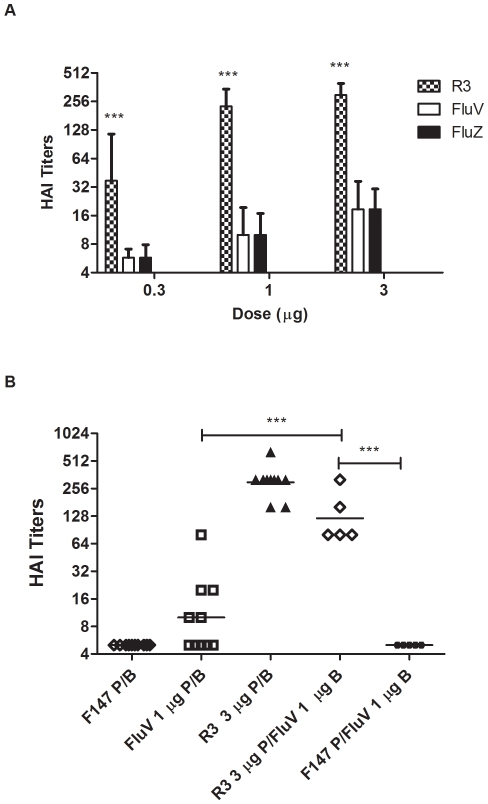
HAI titers of mice immunized with STF2R3.HA1, and/or TIV.Mice (n = 10) were primed (P) and boosted (B) with F147, STF2R3.HA1 (R3), Fluvirin (FluV), or Fluzone (FluZ) at the indicated doses on days 0 and 21, and bled on day 42 (A). Separate groups of mice (n = 5) were primed with 3 µg of STF2R3.HA1 or F147, and boosted with 3 µg Fluvirin (B). Neutralizing antibody titers were measured by HAI test, and expressed as GMTs +95%CI (A) or GMTs (B). Doses of Fluvirin and Fluzone are given according to the contents of H1N1 HA. ***, p<0.001 in 2-way ANOVA/Bonferroni test (A) or 1-way ANOVA/Tukey test (B).